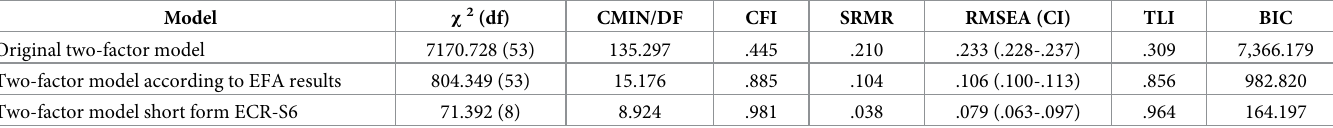
Table 3. Summary of fit indices of different factor